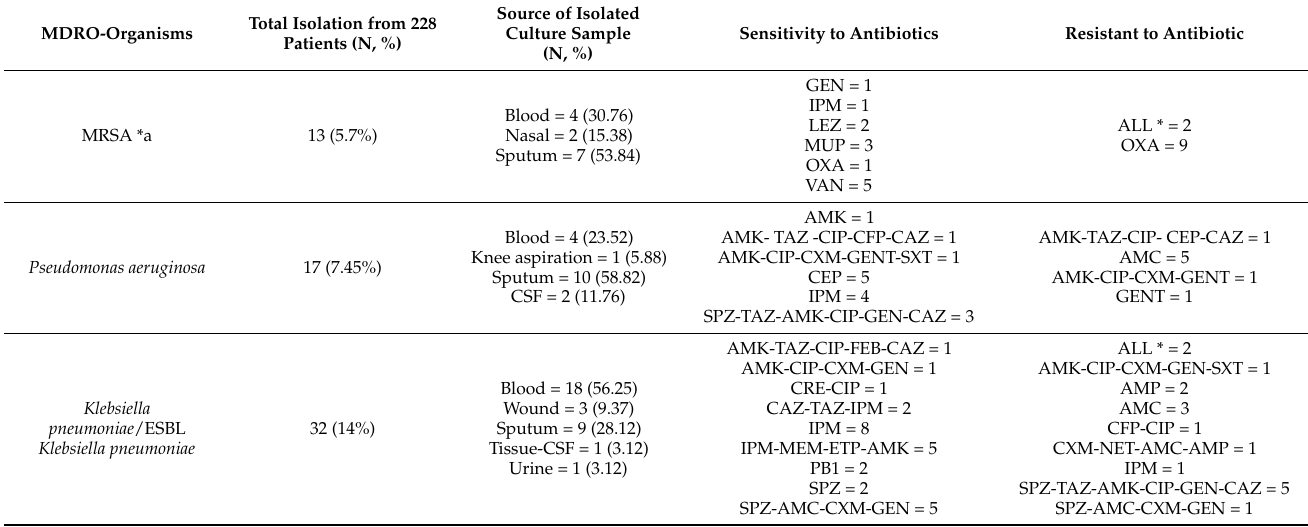
Table 3. The sensitivity patterns of MDRO organisms and their main sources of isolated culture